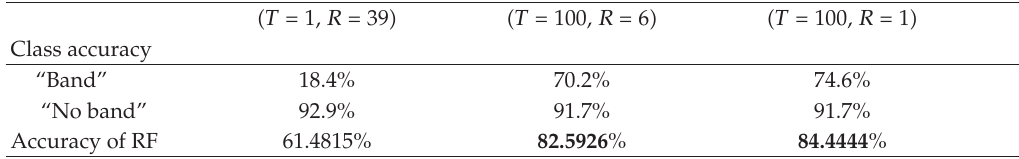
Table 2: The accuracy of trial random forests (cid:6) RF (cid:7) for each class with di ff erent